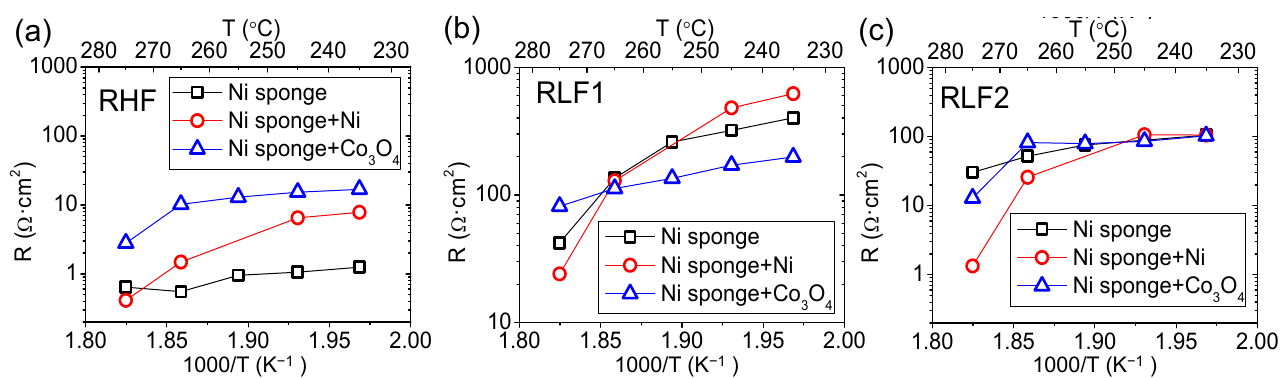
Figure 10. Equivalent electrical circuit fitting results: ( a ) resistances at high frequencies, ( b ) low frequency 1, and ( c ) low frequency 2 or Rchem for bare Ni sponge.